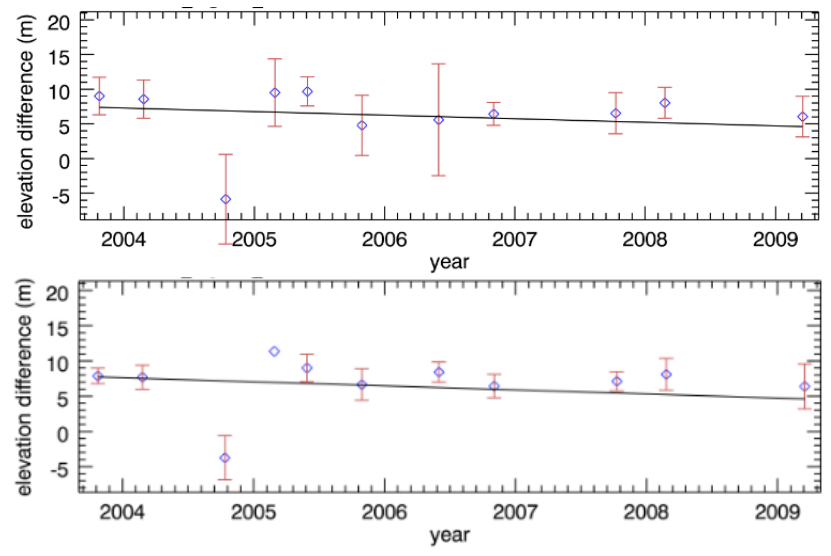
Figure 5. Linear trend of the surface lowering in area A1 fitted through multi-seasonal ICESat data. Snow corrections and a threshold for the local terrain slope of 10° (above) and 5° (below) were applied to reduce the high in-track variation of